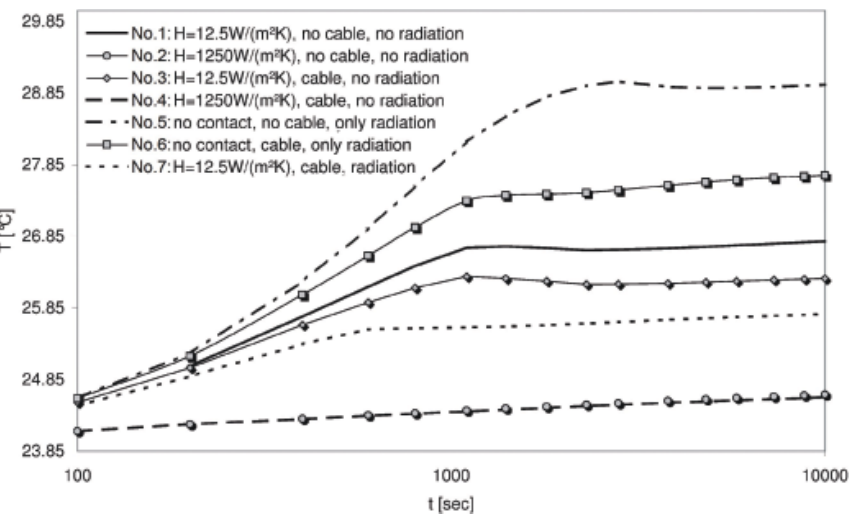
Fig. 19. Temperature response of the LNP03-sensor (short thick needle) at the measurement point due to heating in a moderate conductivity sample with λ = 0 . 2Wm − 1 K − 1